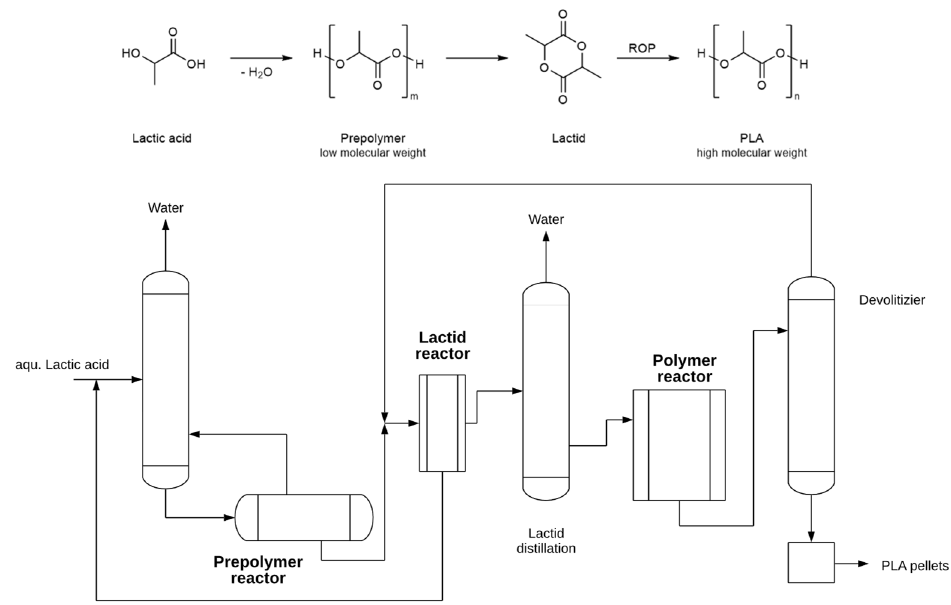
Figure 4. Schematic diagram of a typical combined lactide/ROP process for production of PLA.